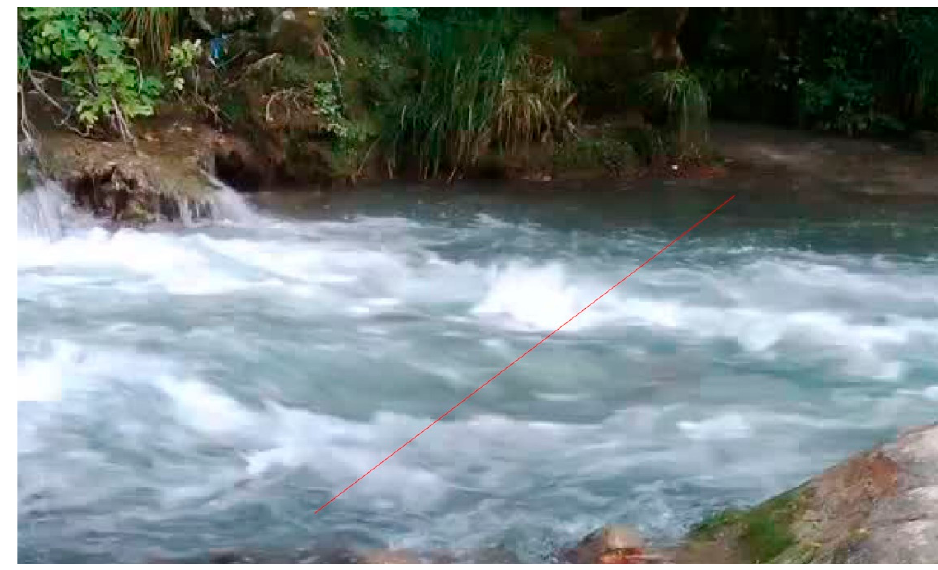
Figure 7. A part of the frame from the Loussios River upstream Atsicholos Bridge video; the surface velocities are estimated along the displayed red line.